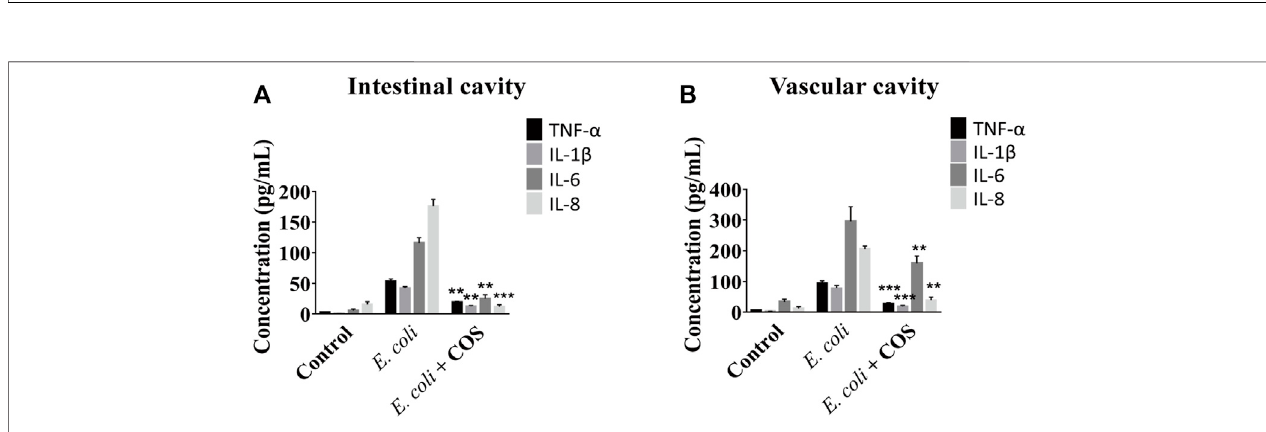
FIGURE4| Regulatoryeffect ofCOS onmicrobialhomeostasisinenteritismodel. (A) Absorbancevalueof E.coli solutionaftertreated withCOS,5-Anior1%P/S. (B) Absorbance value of out fl owsolution inthe intestinal cavity or vascular cavity. (C) Absorbancevalue of out fl ow solution inthe enteritison achip withor without COS. Data were represented as mean ± SD ( n = 3); One-way ANOVA test and Student ’ s test were performed, * p < 0.05, **** p < 0.0001.